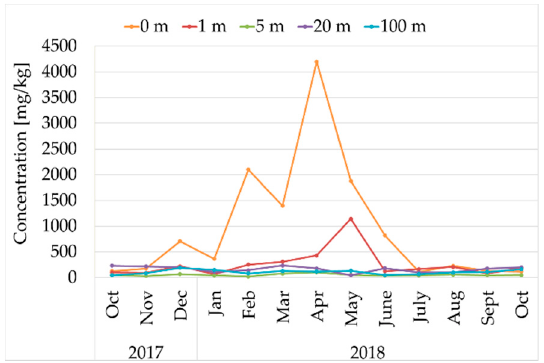
Figure 9. Chloride concentrations in soils at Site B measured at five distances from the motorway [mg/kg].